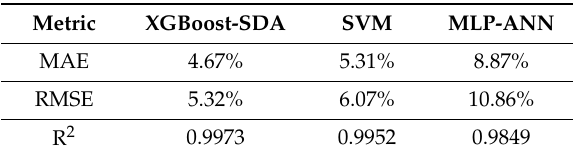
Table 5. Performance comparison of XGBoost-SDA, support vector machines (SVM), and multilayer perceptron artificial neural networks (MLP-ANN).